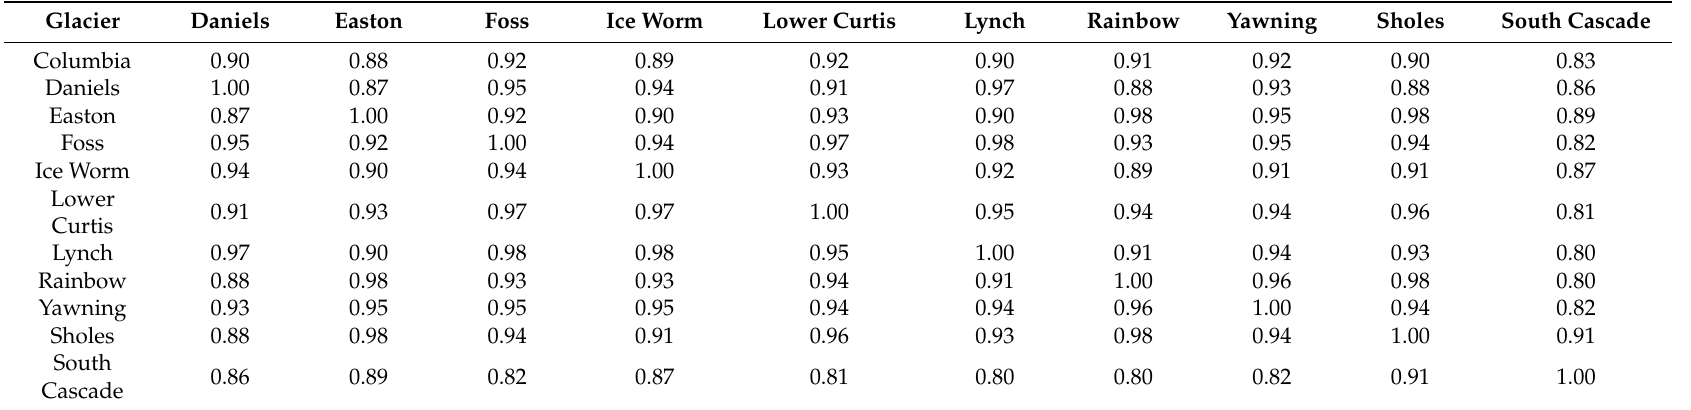
Table 3. Cross-correlation of annual balance on the North Cascade glaciers from 1984–2014, except for the Sholes Glacier and the Easton Glacier from 1990 to 2014. The South Cascade Glacier has been observed by the USGS from 1985 to 2012, all of the other glaciers data is from the NCGCP. Glacier